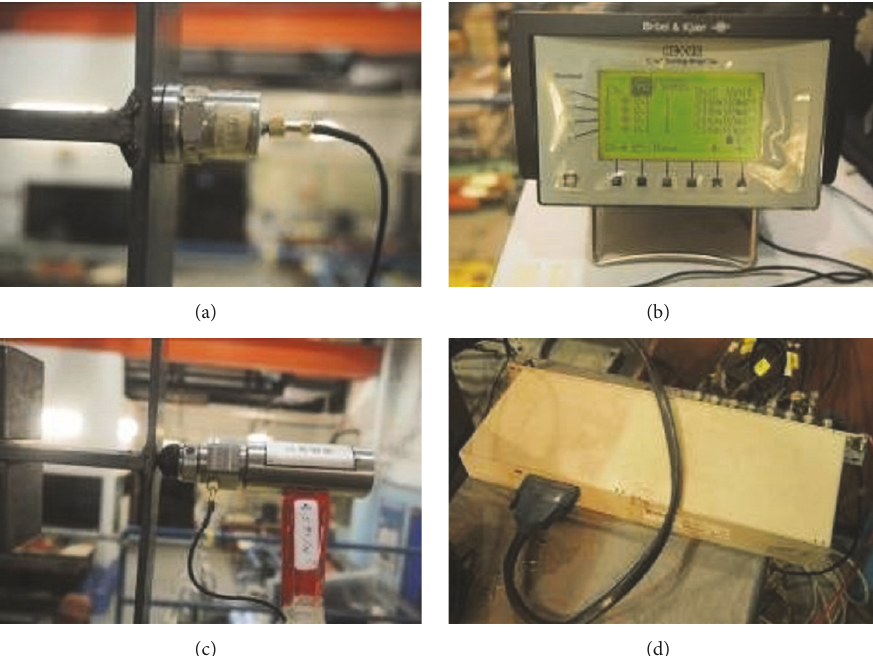
Figure 8: Instruments adopted in the test. (a) B&K 3023 accelerometer. (b) B&K Nexus amplifier. (c) Hammer. (d) NI data acquisition